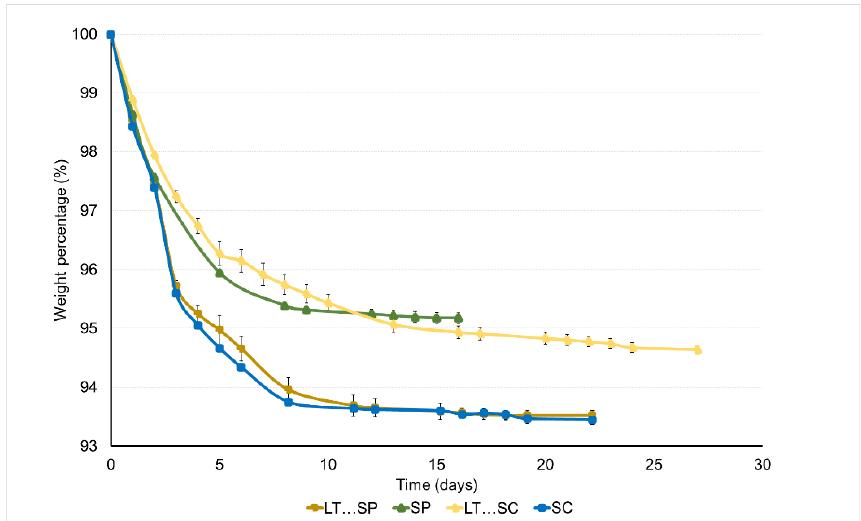
Figure 1. Fermentation kinetics of gravimetrically measured variants by total weight loss during fermentation. S. cerevisiae alone (SC); sequential fermentation with S. cerevisiae and L. thermotolerans (LT . . . SC); sequential fermentation with S. pombe and L. thermotolerans (LT . . . SP); S. pombe alone (SP). Data points represent the averages and standard deviation of the three replicates for each condition. SC fermentations are in blue; SP fermentations are in green; LC . . . SC fermentations are in yellow; LT…SP fermentations are in brown.